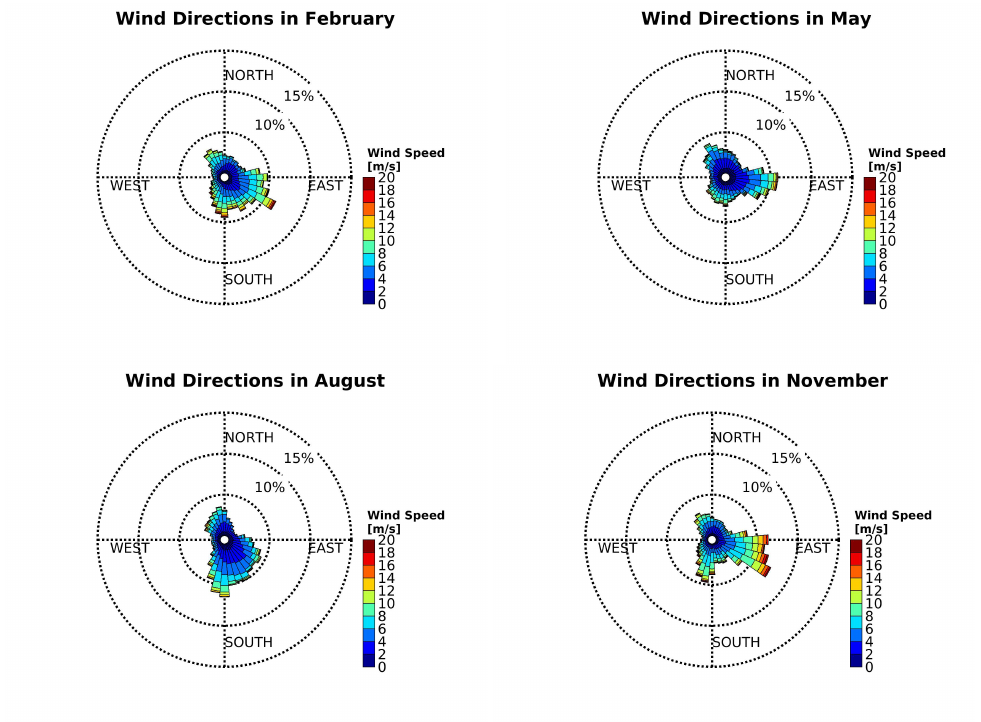
Figure 6. Wind roses at 800 m altitude in February ( top , left ), May ( top , right ), August ( bottom , left ) and November ( bottom , right ) of the years